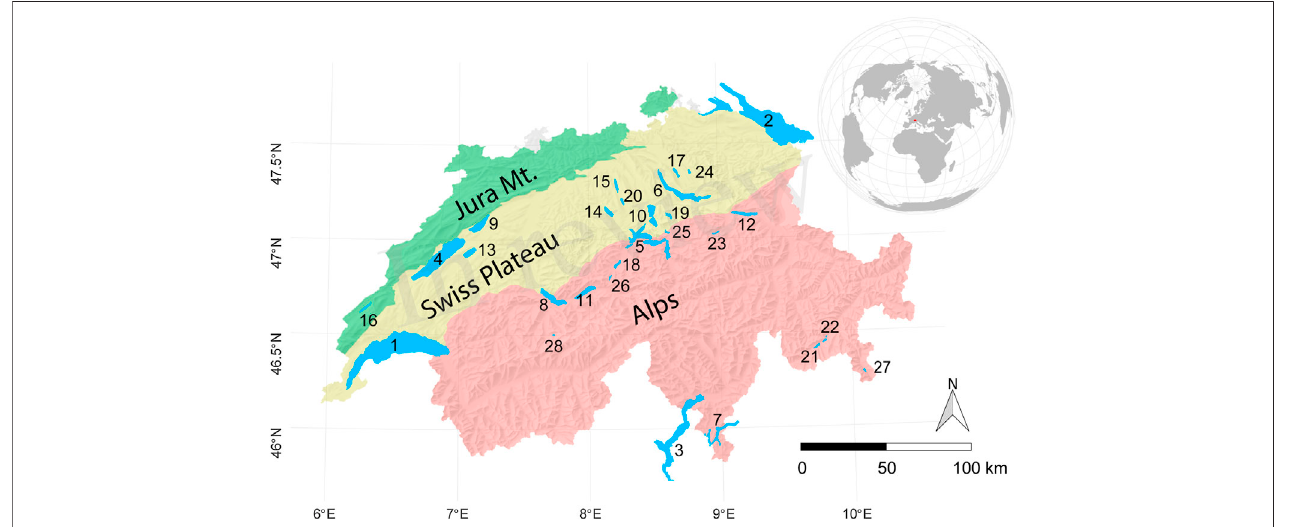
FIGURE 1 | Location of the Swiss (non-reservoir) lakes with surface areas < 1 km. Labels refer to Table 1 . Geodata used with permission from swisstopo.